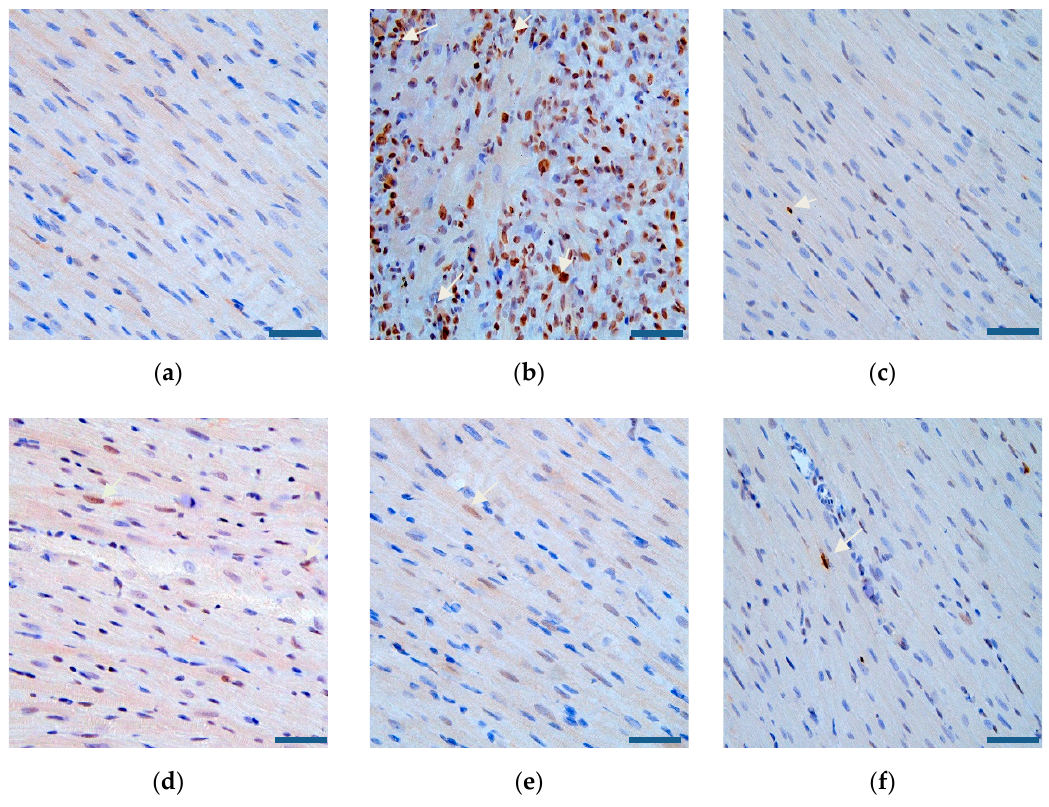
Figure 13. Cardiomyocyte apoptosis of rats (×400, scale bar = 200 μ m) in ( a ) the sham group, ( b ) the model group, ( c ) the positive drug group, ( d ) the miR-133 group, ( e ) the PEG-PLA/miR-133 group, and ( f ) the RGD-PEG-PLA/miR-133 group. Blue: the nucleus of normal cells, brown: the nucleus of apoptotic cells. White arrows indicate the nucleus of apoptotic cells.